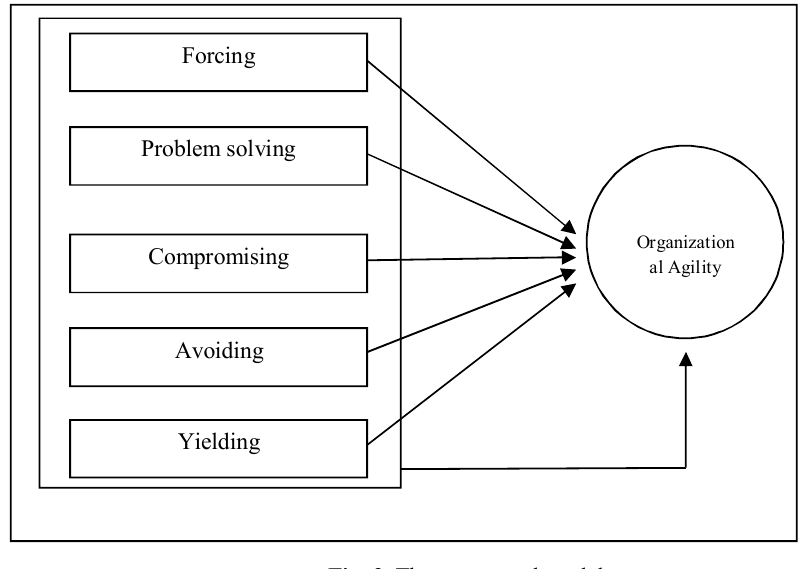
Fig. 2. The conceptual